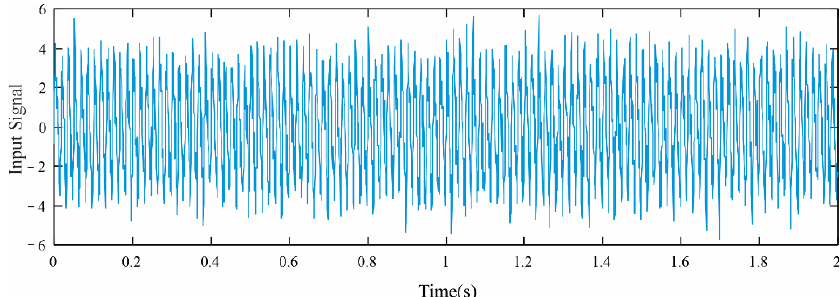
Figure 7. Synthetic signal with 10 dB of white Gaussian noise.